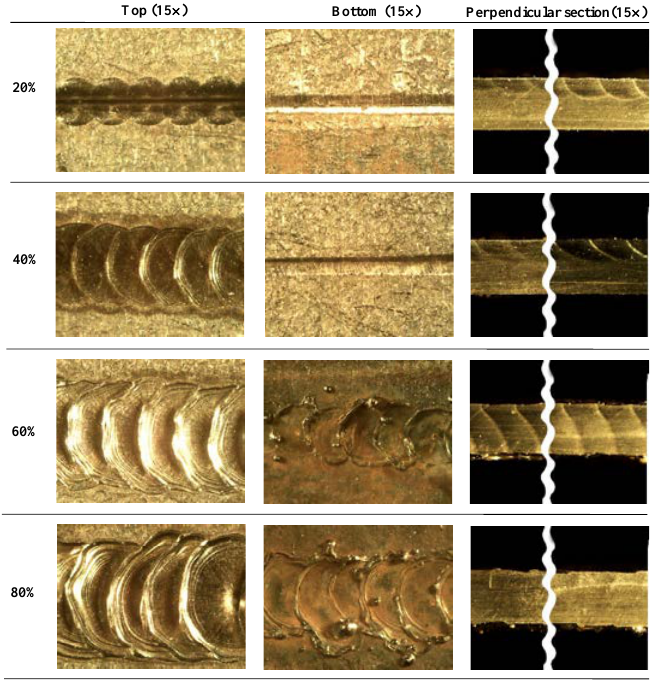
Figure 8. Comparison of weld surfaces under different laser beam powers.